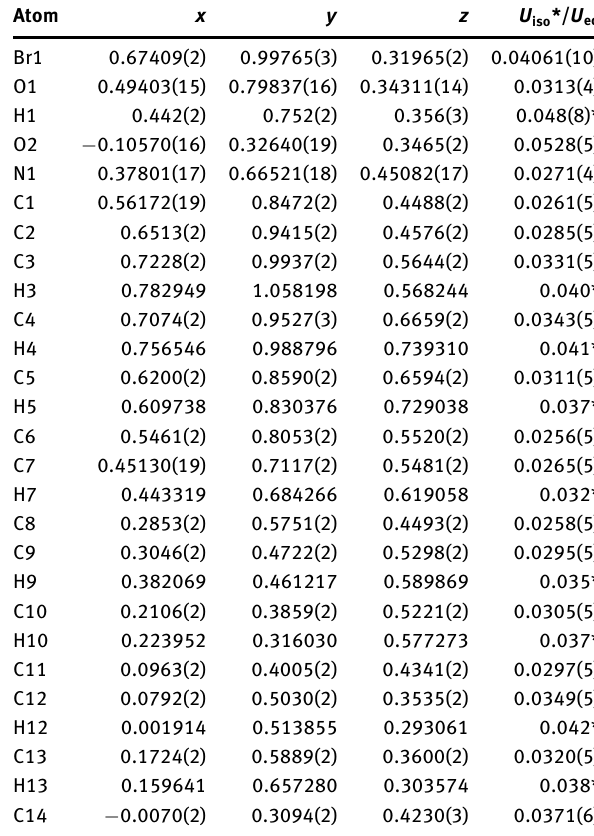
Table 2: Fractional atomic coordinates and isotropic or